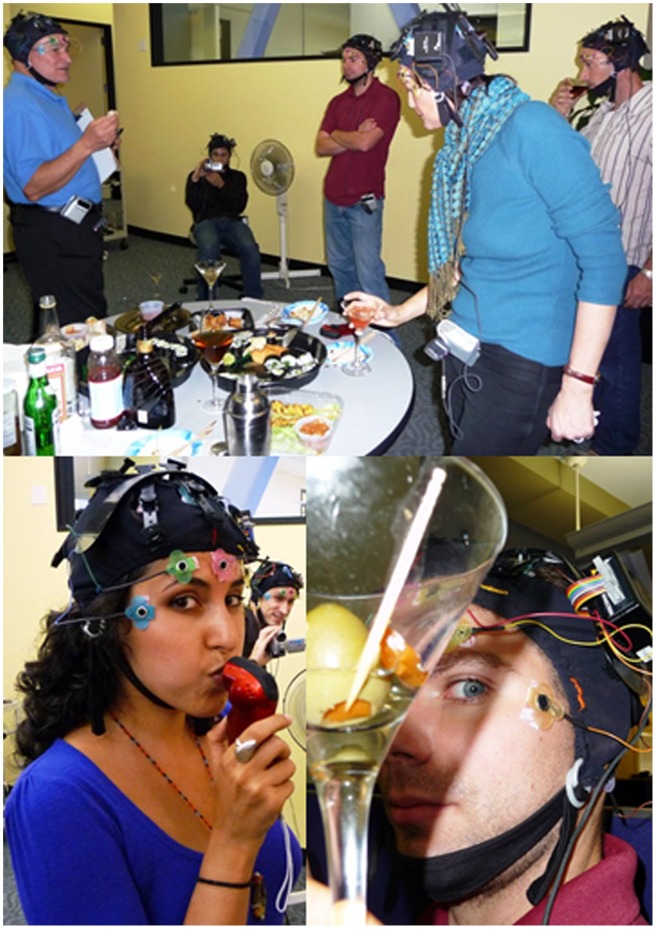
EEGs of ten ambulatory participants simultaneously measured during a cocktail party.EEGs were recorded and transmitted to PCs while the partiers chatted, ate sushi and hors d'oeuvres and drank vodka martinis or vodka and cranberry cocktails according to their personal inclinations. Participants also measured breath alcohol contents, took photos and checked the data collection (lower photos). The six participants shown in photos have given written informed consent, as outlined in the PLoS consent form, to publication of their photograph.